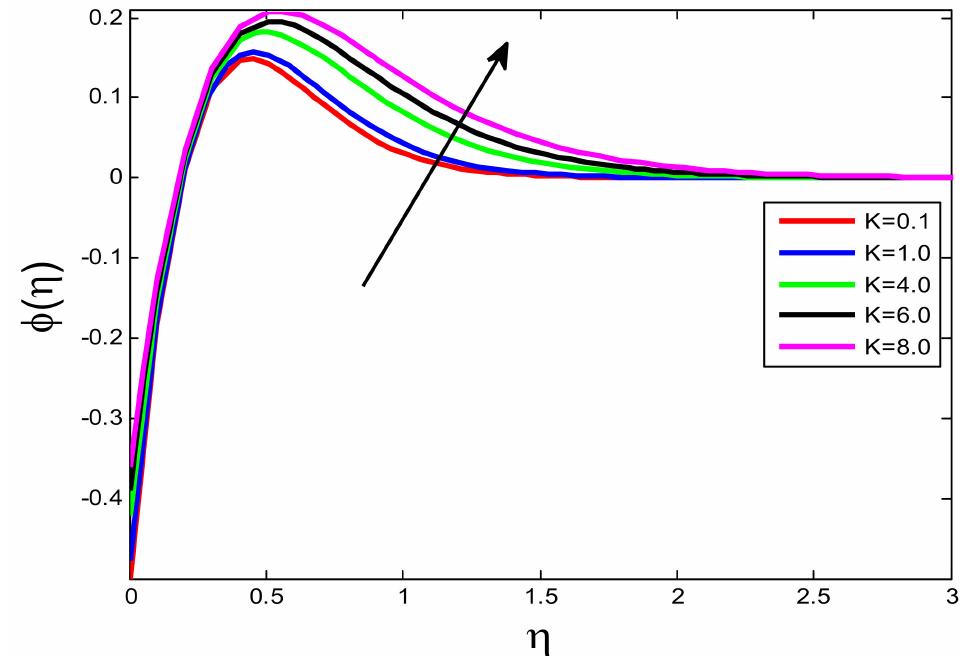
Figure 12. Influence of K on φ ( η ) .